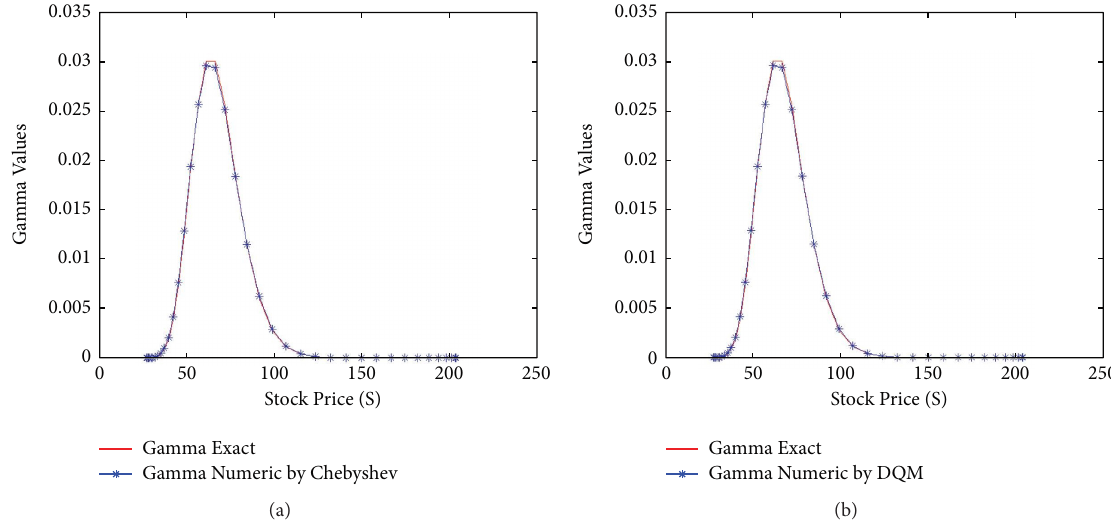
Figure 14: 2D plot exact and numerical values of gamma at time t � 0. (a) is for the Chebyshev method, and (b) is for the DQM.